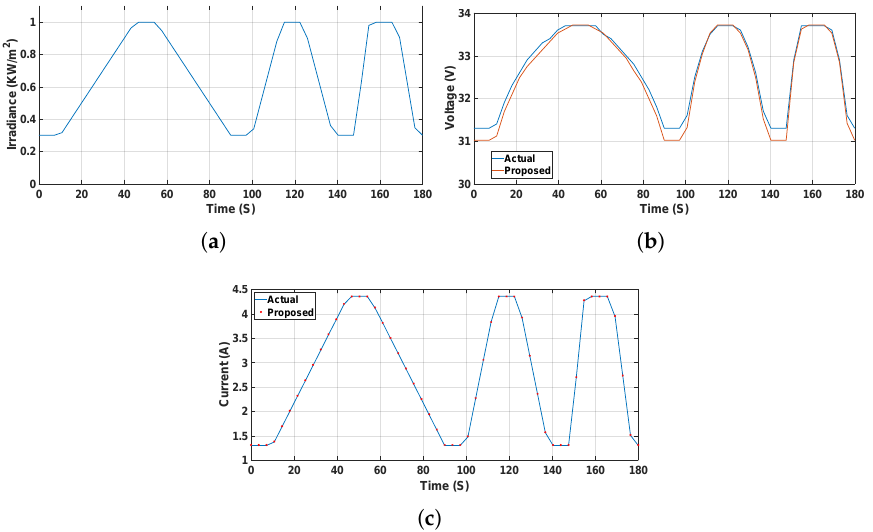
Figure 12. ( a ) Irradiance at gradients of 20, 50, 100 W/m 2 /s ( b ) accuracy of the Proposed algorithm in finding V mpp at gradients of 20, 50, 100 W/m 2 /s ( c ) accuracy of the Proposed algorithm in finding I mpp at Gradients of 20, 50, 100 W/m 2